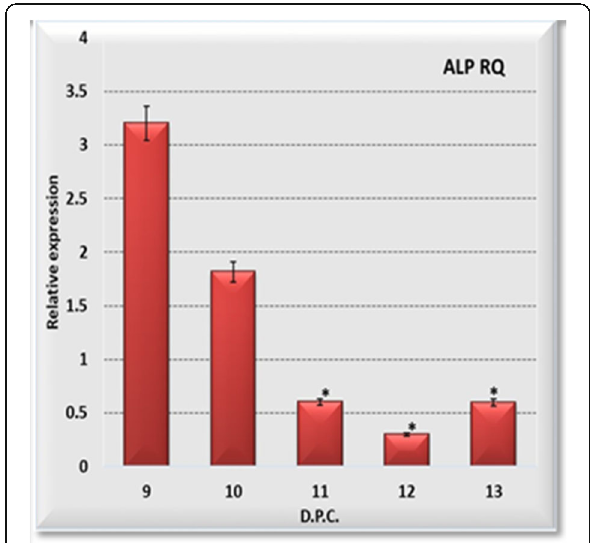
Fig. 2 Histogram representing the gene expression of Alkaline phosphatase (CDHI), at the embryonic stages E9.5 to E13.5 of rat embryos ( Rattus norvegicus ).* means significant against 11 D.P.C. group. P <